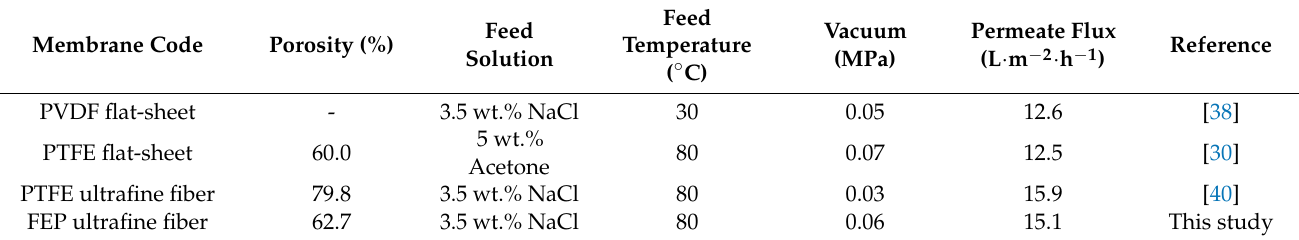
Table 4. Permeate flux in this study compared with other membranes in VMD